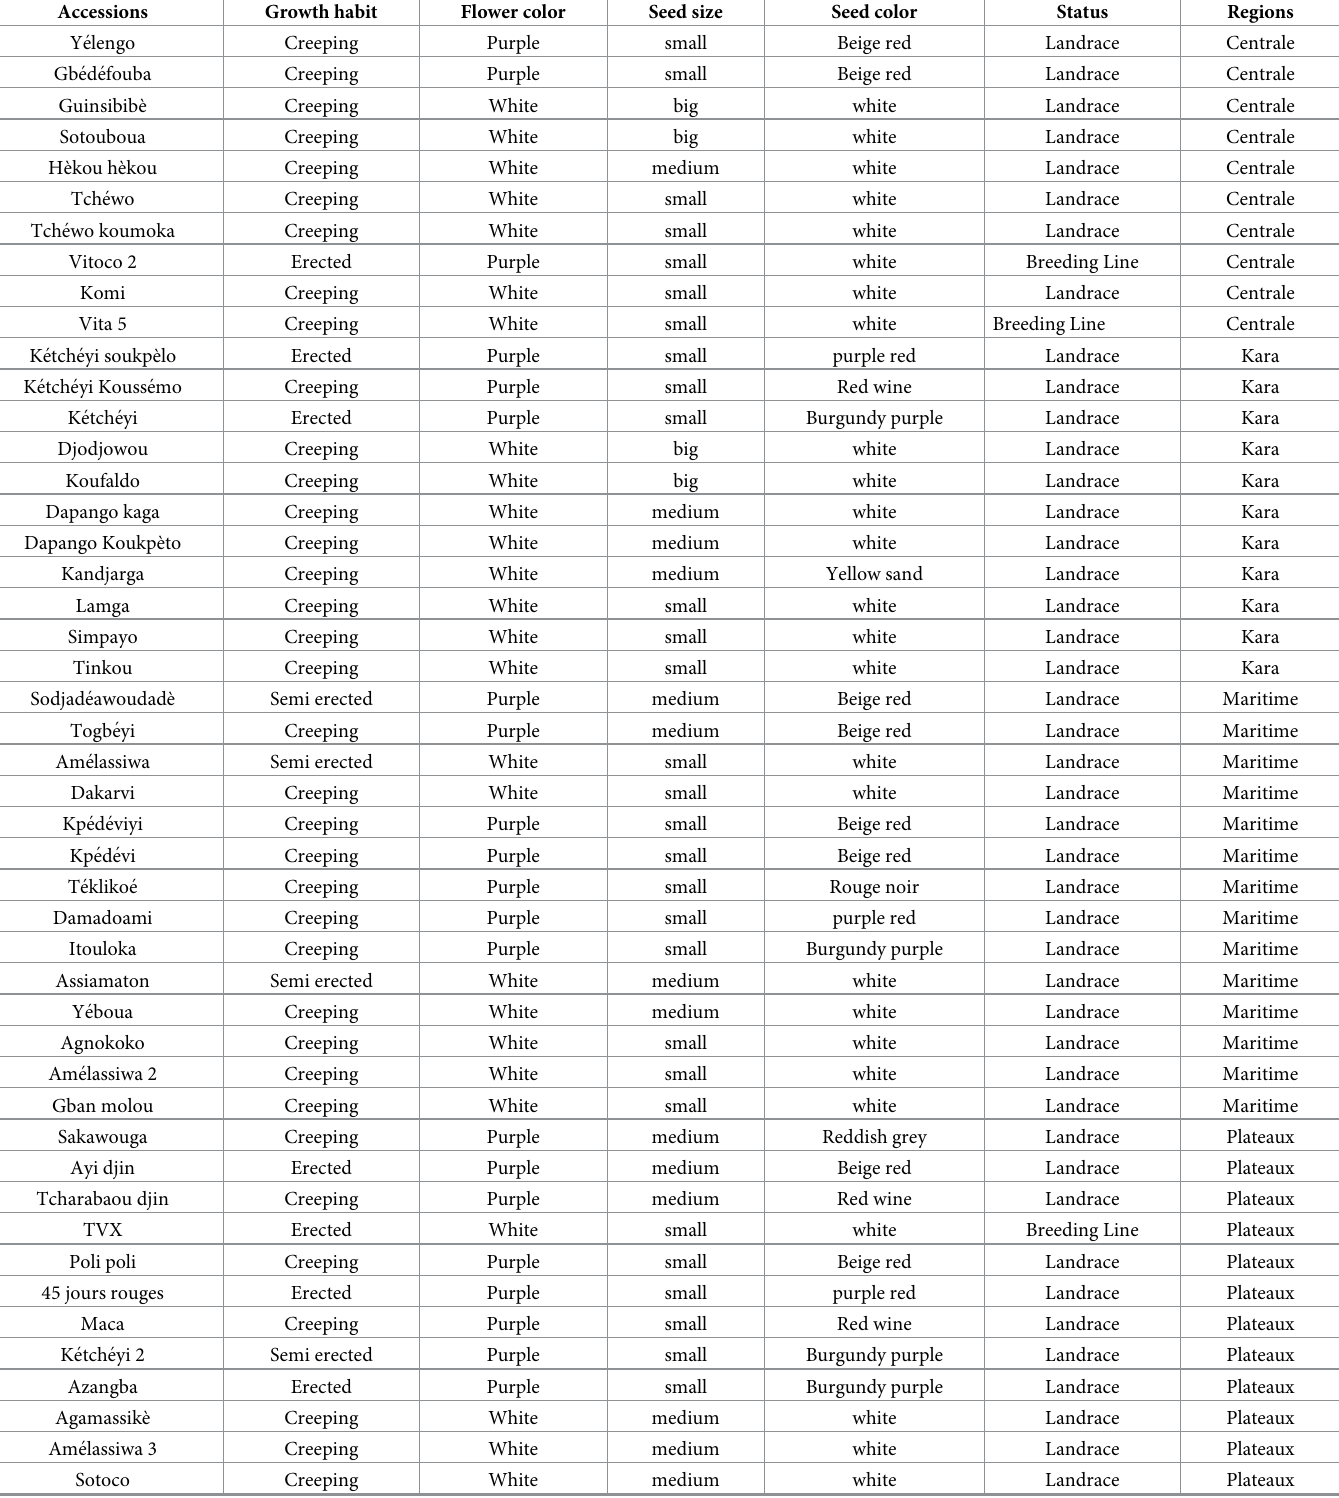
Table 1. List of the Cowpea accessions, characteristics and collection.